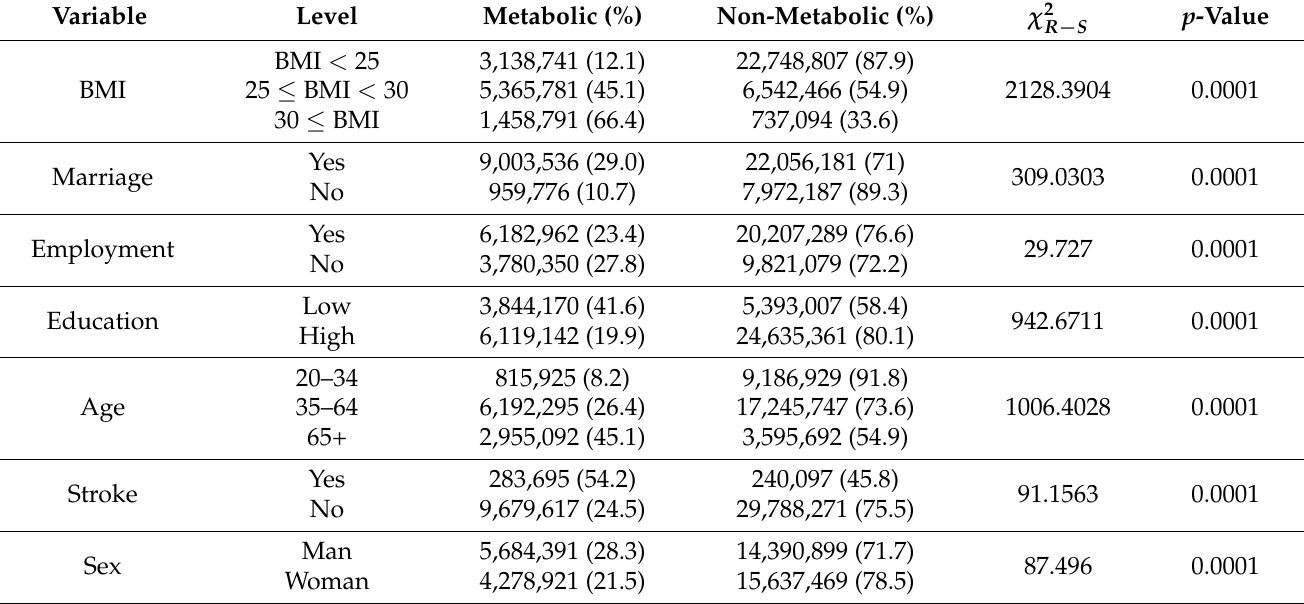
Table 1. Rao-Scott chi-squared test result for 14 risk factors associated metabolic